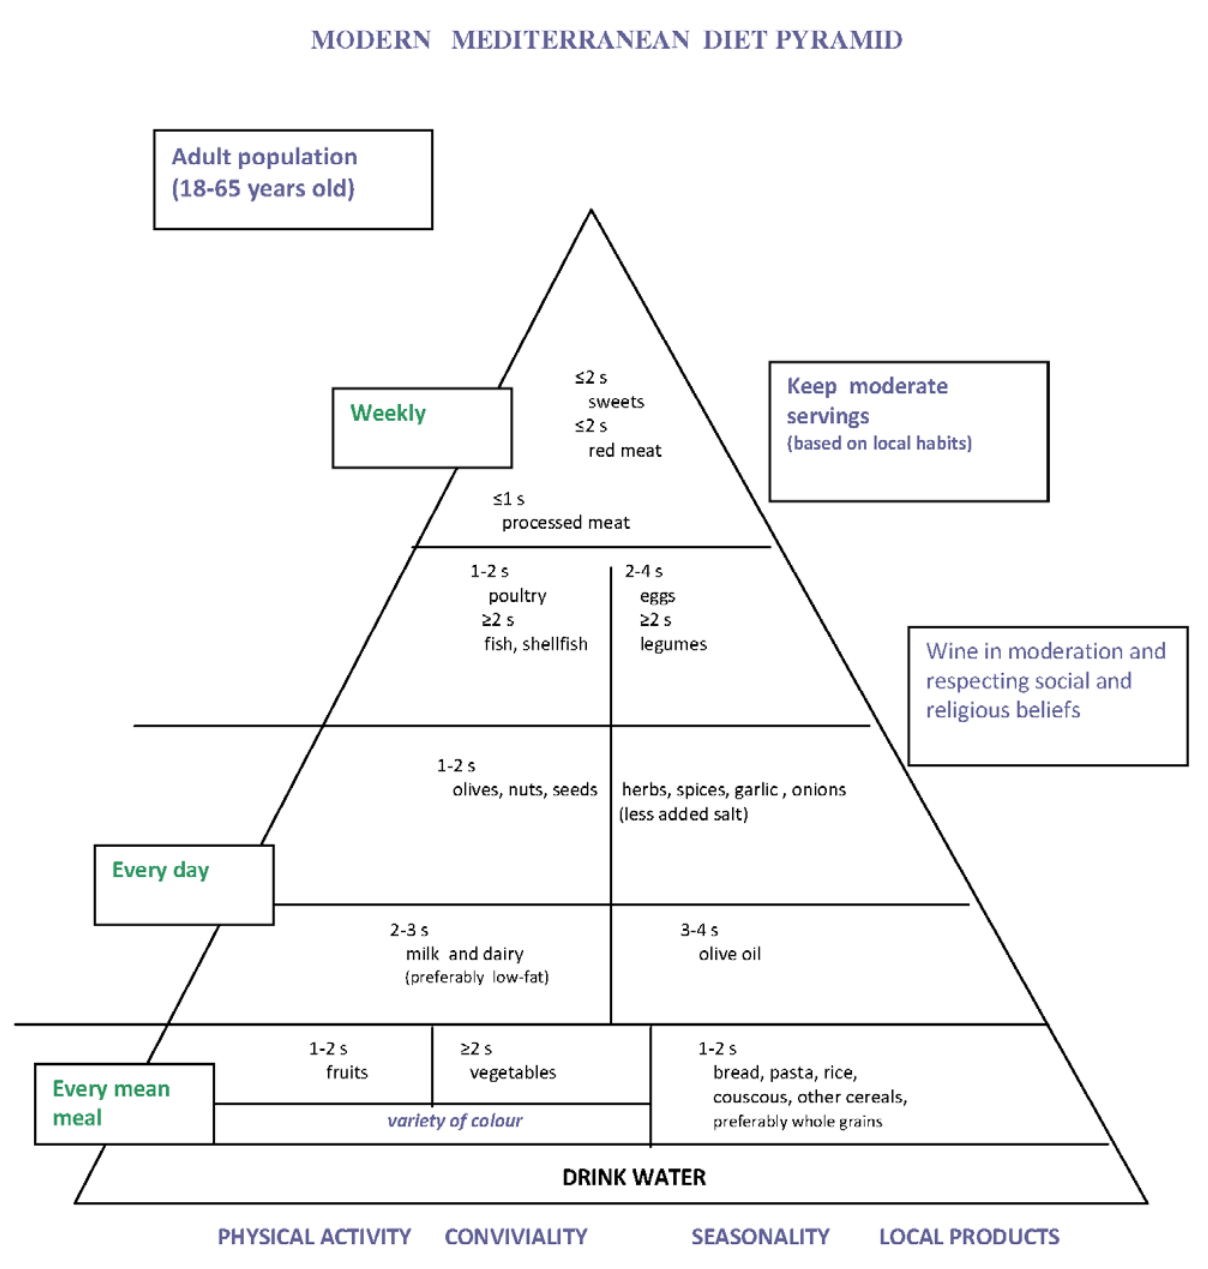
Figure 1. Modern Italian diet pyramid presented during the third CIISCAM conference in Parma, Italy, on November 3, 2009 [6]. (CIISCAM: Centro Interuniversitario Internazionale di Studi sulle Culture Alimentari